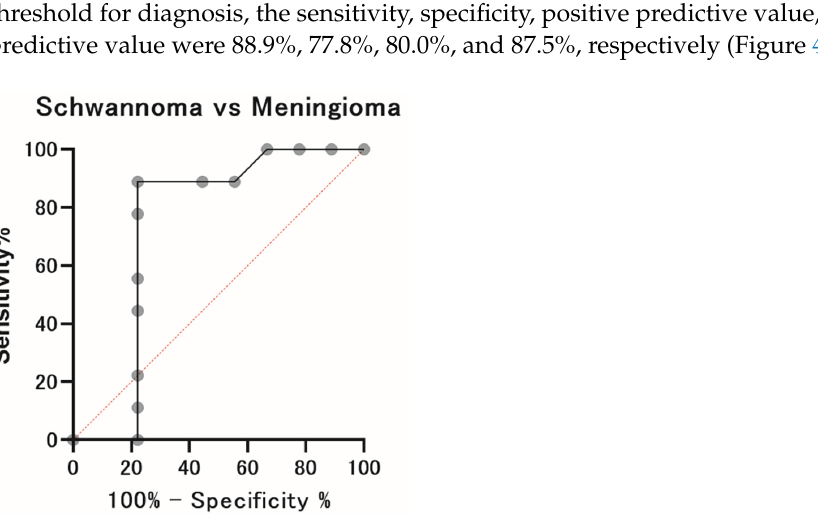
Figure 4. ROC analysis. ROC analyses demonstrated moderate discriminatory power for mean MTR asym to differentiate between patients in the schwannoma group and meningioma group. When an AUC value of <0.024 was used as the threshold for diagnosis, the sensitivity, specificity, positive predictive value, and negative predictive value were 88.9%, 77.8%, 80.0%, and 87.5%,